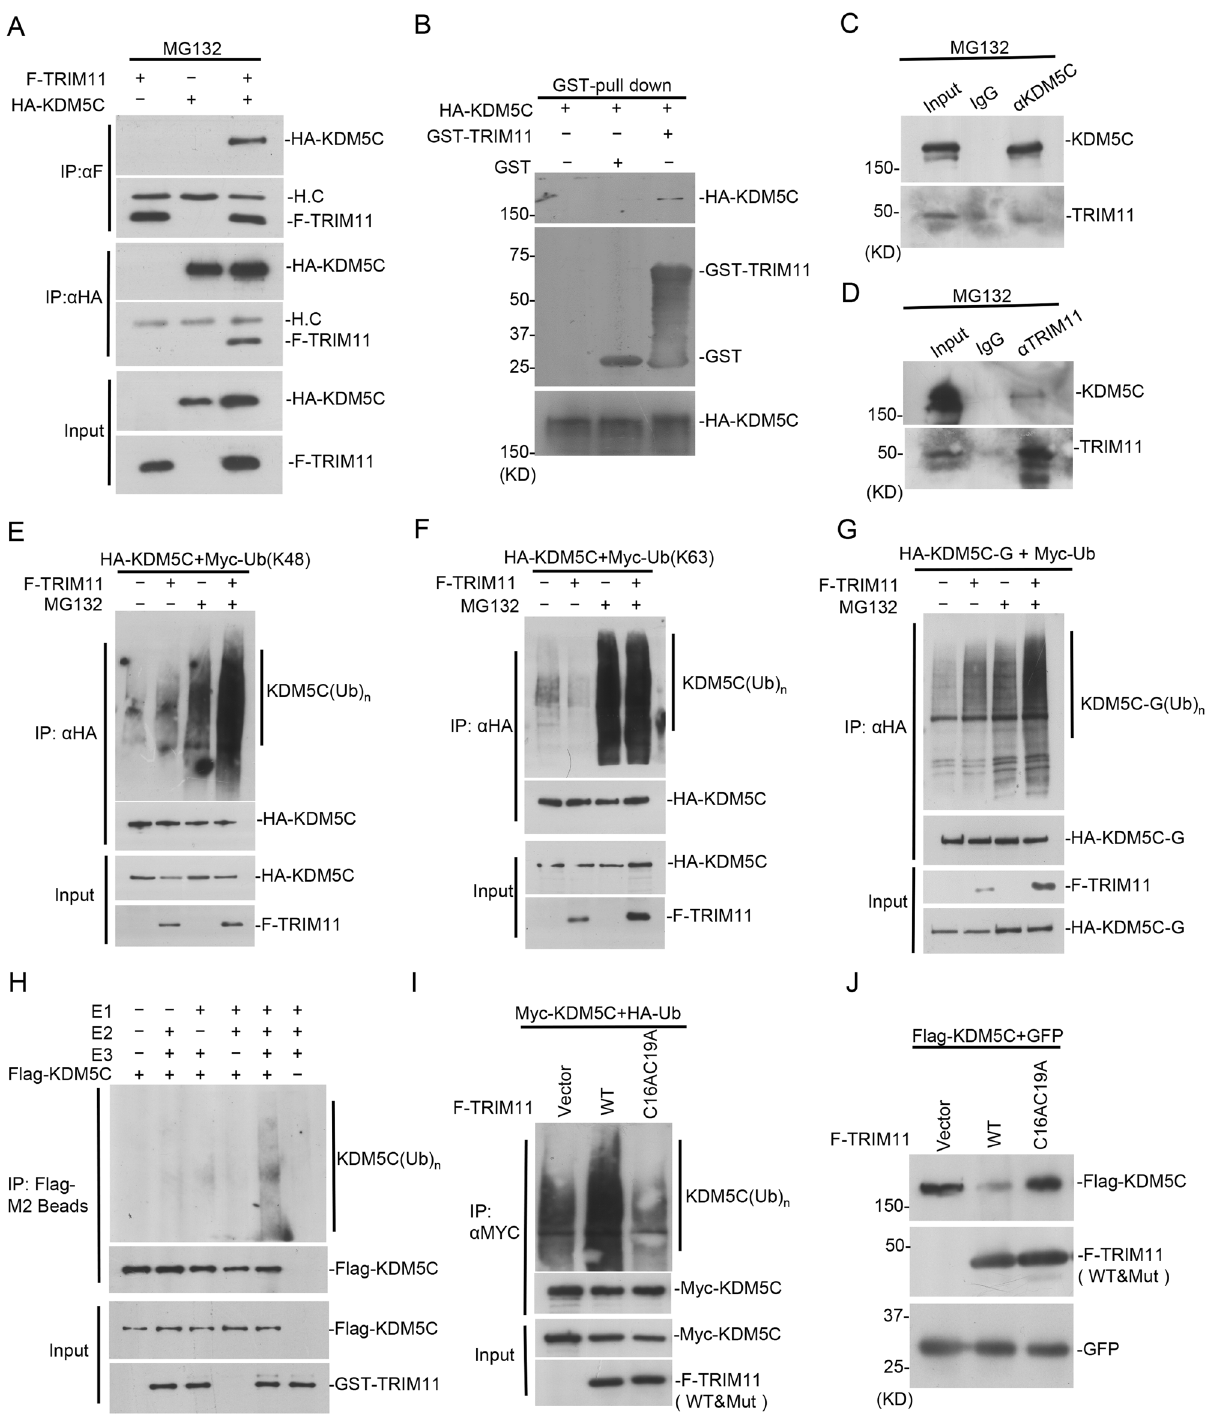
Fig. 2 TRIM11 interacts with and poly-ubiquitinates KDM5C. A 293T cells were transfected with indicated plasmids for 36 h and treated with 10 μ M MG132 for 12 h. Co-IP was performed with anti-Flag and anti-HA antibody. B GST-TRIM11 was expressed and puri fi ed from bacteria. HA- KDM5C was expressed in 293T cells and lysates were subject to GST pulldown assay. C , D MDA-MB-231 cells treated with MG132 were used for co-IP with KDM5C and TRIM11 antibodies, followed by western blot analysis. E – G 293T cells were transfected with HA-KDM5C ( E , F )/HA- KDM5C-G ( G ), F-TRIM11 and Myc-Ub (WT/K48/K63) plasmids for 36 h followed by MG132 (10 μ M) treatment for 12 h. Cell lysates were subjected to immunoprecipitation with anti-HA followed by western blot with anti-Myc. H In vitro ubiquitination assay was performed in the presence of Ub, E1, E2(UbCH5b), bacteria-puri fi ed GST-TRIM11 and 293T-puri fi ed Flag-KDM5C. I 293T cells were transfected with Myc-KDM5C, HA-Ub, F-TRIM11(WT) or F-TRIM11(C16AC19A). Ubiquitination of KDM5C was measured. J Flag-KDM5C, F-TRIM11(WT) and F- TRIM11(C16AC19A) were expressed in 293T cells and western blotting was performed as indicated.